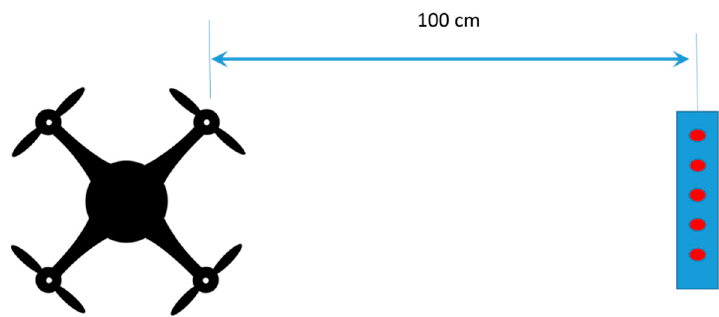
Figure 7. Elements distribution on Setup 1.